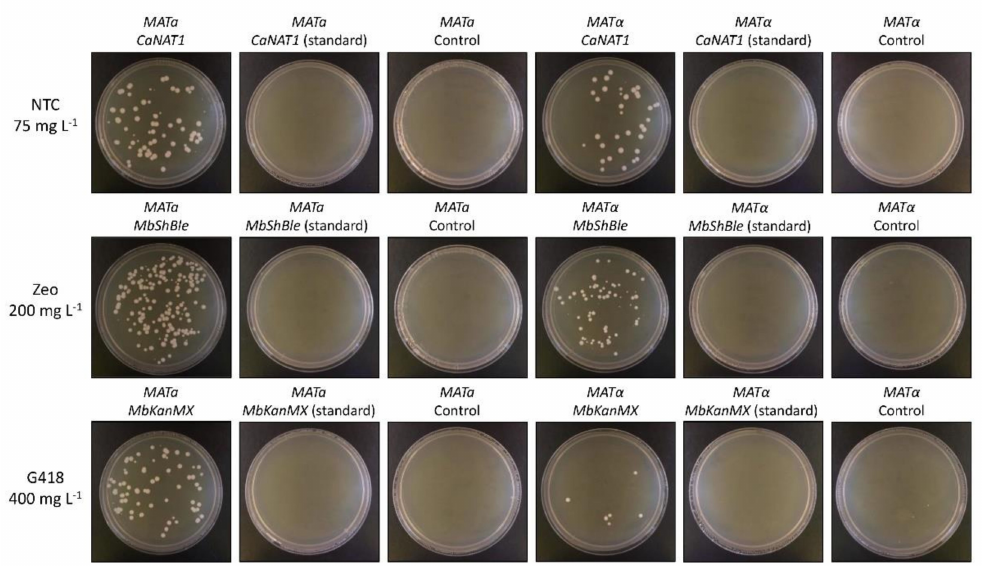
Figure 2. Electroporation of M. borealis with CaNAT1 , MbKanMX , and MbShBle in standard and yeast alternative nuclear code. Electro-competent cells of M. borealis ( MATa and MAT α ) were transformed with 1 µ g of PCR-amplified CaNAT1 , MbShBle , or MbKanMx , in standard or alternative code, flanked by 60 base-pair sequences of the M. borealis ADH1 promoter and terminator, using the electroporation protocol outlined in this study. After recovery, 20 µ g of each transformation was plated on YPAD with the appropriate antibiotic and incubated at 30 ◦ C for two days. NTC = nourseothricin; Zeo = zeocin; G418 =